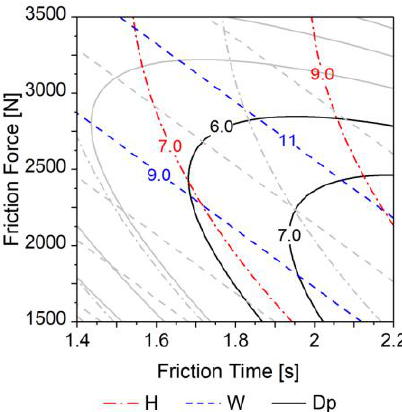
Figure 22. Influence of most relevant joining parameters FF and FT on joint formation (H, W and Dp). Values in millimeters. Regions of interest delimited by colored lines. RS is set at 21,000 rpm, FoT at 1.5 s and FoF at 4500 N.